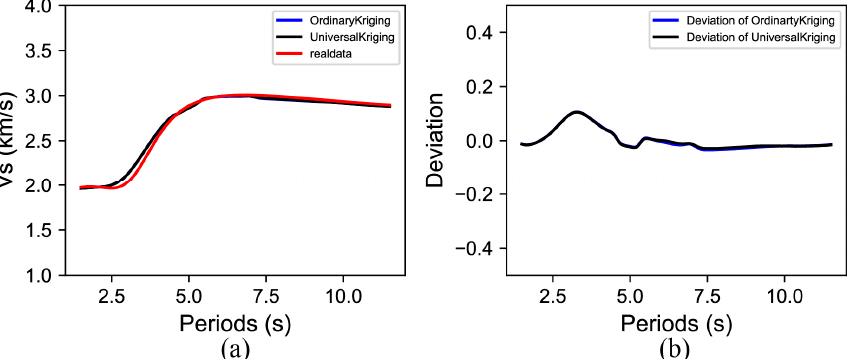
Figure A4. Comparison of dispersion curve interpolation results (128.09° E, 41.88° N ). The blue curve indicates the ordinary kriging results, while the black curve indicates those of universal kriging: ( a ) Comparison of the dispersion curves; and ( b ) deviation of the OK (blue) or UK (black) results.